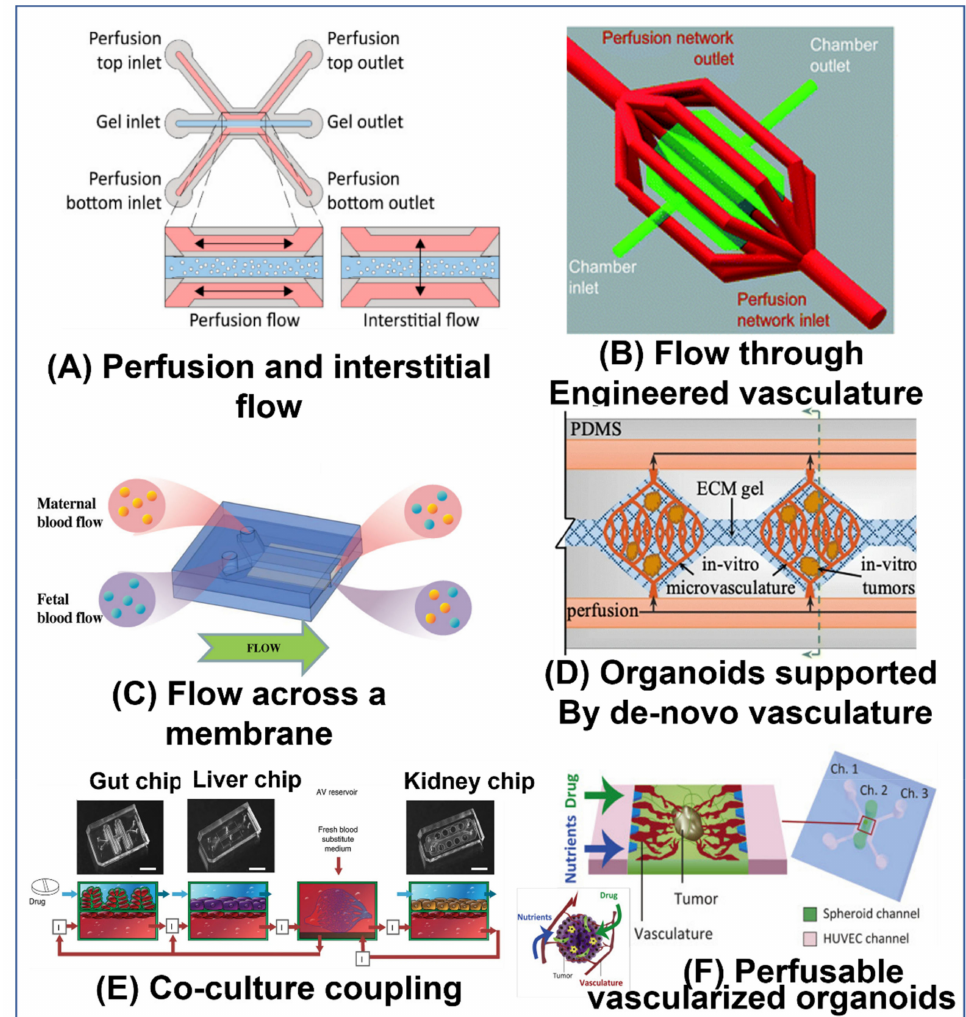
Figure 4. Organ-on-a-chip models that incorporate perfusion: ( A ) Pancreatic ductal adenocarci- noma cells (PDAC) were cultured in a microfluidic chip. Perfusion through the side media channels was controlled by a programmable rocker. To mimic interstitial flow, perfusion across the cell cul- ture chamber was induced by filling the media reservoirs to different heights. The interstitial flow was used to mimic the intratumoral fluid pressure present in such tumors in vivo [51]. Reprinted with permission from International Journal of Molecular Science; published by MDPI, 2019. ( B ) A culture chip with an engineered perfusion network was 3D printed using an SLA printer. HT-29 cells (a human colorectal adenocarcinoma cell line with an epithelial morphology) were seeded in the chamber, and media was continuously perfused through the perfusion network. The perfused cul- tures had a higher percentage of live cells after one week of culture compared to static conditions [22]. Reproduced with permission from Lab on a Chip; published by RSC, 2017. ( C ) A membrane based OoC model of the placenta barrier (as described above in Figure 1A) was continuously perfused with media. Caffeine was then added to the flow on the maternal side, and the resulting concentration on each side was measured until reaching a steady state at around seven hours [11]. Reproduced with permission from Global Challenges; published by Wiley, under a Creative Commons CC BY license (https://creativecommons.org/licenses/ accessed on 1 May 2022). ( D ) Human endothelial colony forming cell-derived ECs (ECFC-ECs), NHLF cells, and cancer cells were seeded in a microfluidic device. Constant interstitial flow was maintained to induce vasculogenesis. Eventually the vessels anastomosed to the main channel, allowing the perfusion of the cell culture via the vasculature [43]. Image reproduced from [53]. Image reproduced with permission from Journal of